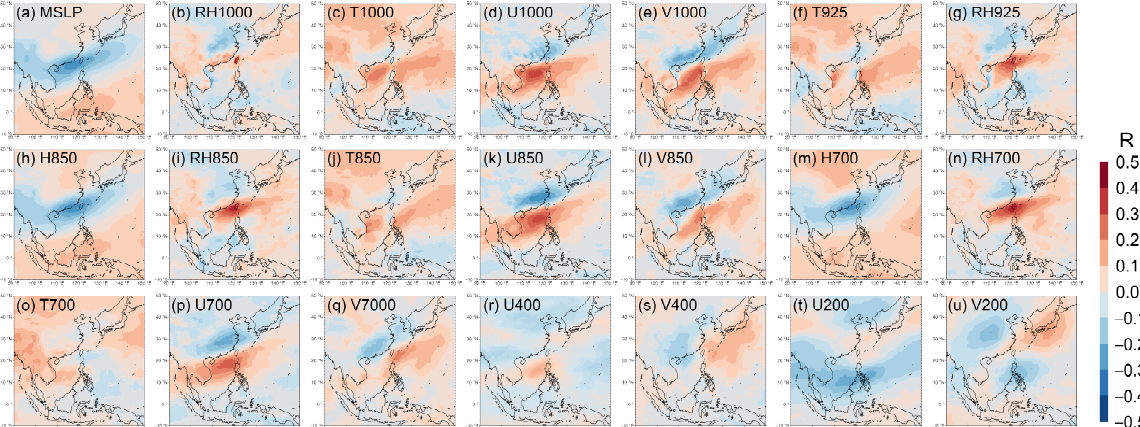
Figure 4. Correlation coefficients of the CFSR variables and Meiyu rainfall in southern Taiwan. ( a ) MSLP, ( b ) RH1000, ( c ) T1000, ( d ) U1000, ( e ) V1000, ( f ) T925, ( g ) RH925, ( h ) H850, ( i ) RH850, ( j ) T850, ( k ) U850, ( l ) V850, ( m ) H700, ( n ) RH700, ( o ) T700, ( p ) U700, ( q ) V700, ( r ) U400, ( s ) V400, ( t ) U200, and ( u ) V200.